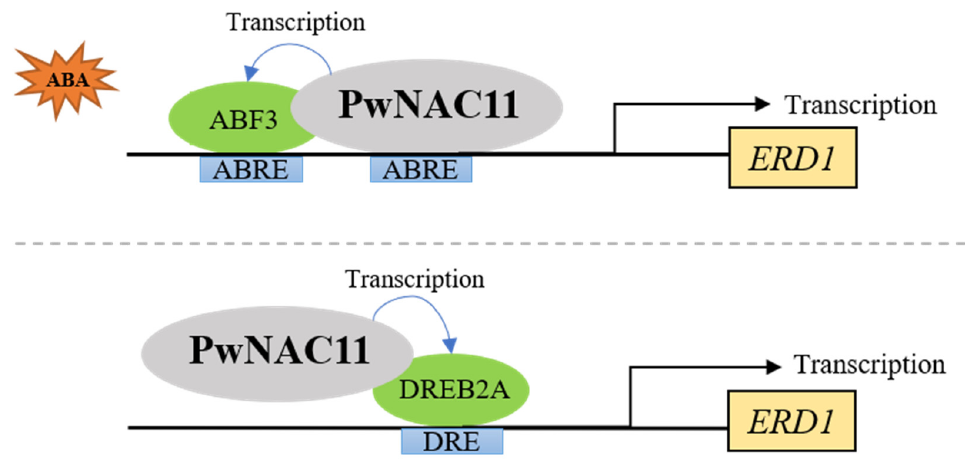
Figure 9. Proposed model of ABA-dependent and ABA-independent abiotic stress responses via PwNAC11.